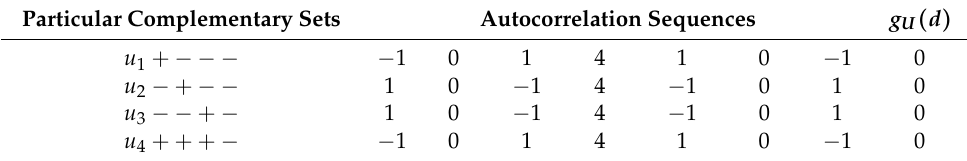
Table A1. Example for the illustration of Property 1 ( L = 4).